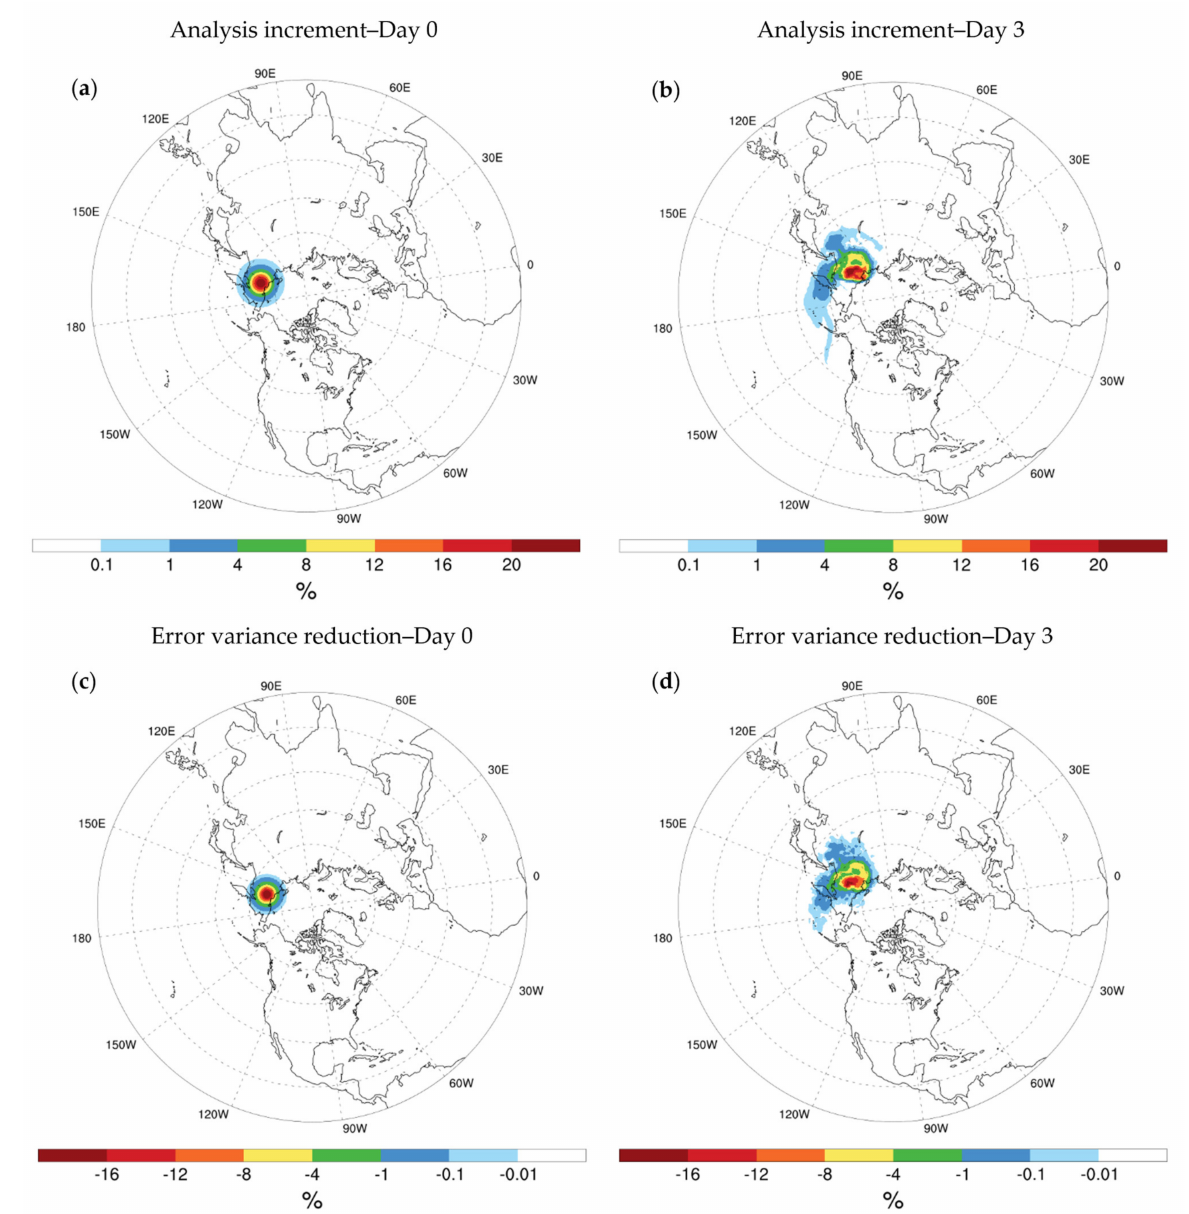
Figure 6. The first one-observation experiment near the surface at higher latitude (71 ◦ N,155 ◦ E) to show ( a ) the analysis increment at Day 0 and ( b ) Day 3; and ( c ) the error variance reduction at Day 0, and ( d ) Day